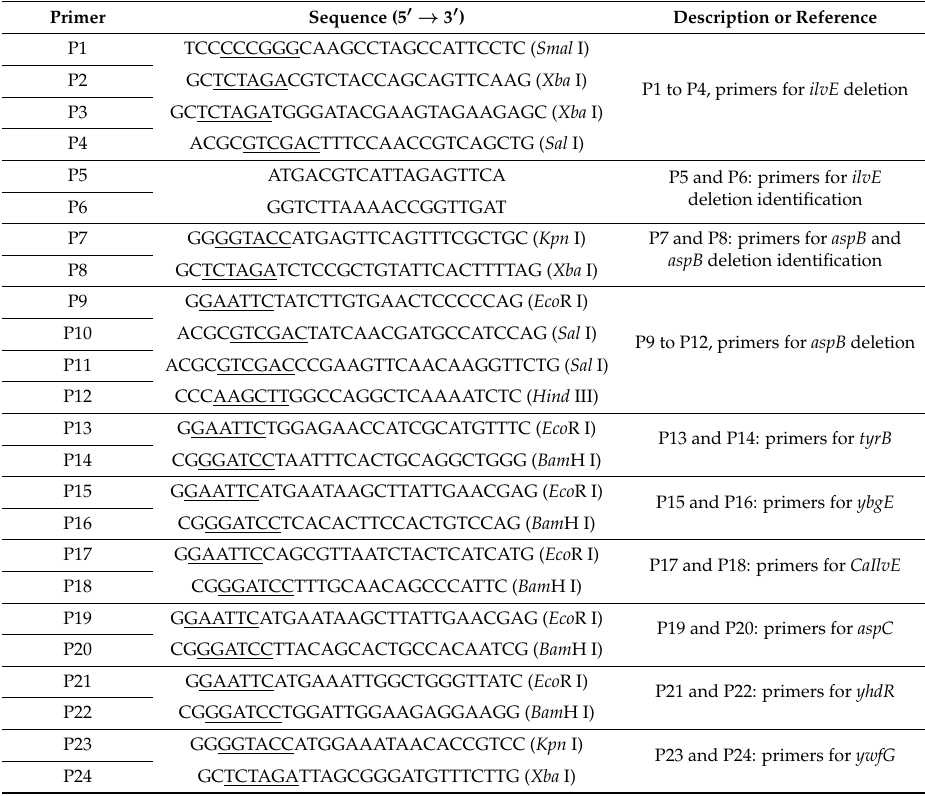
Table 5. Primers used in this